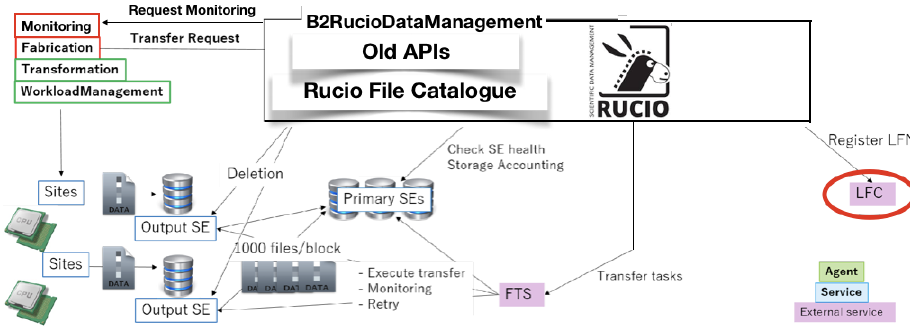
Fig. 4. The Belle II Distributed Data Management System at the initial step of migration to